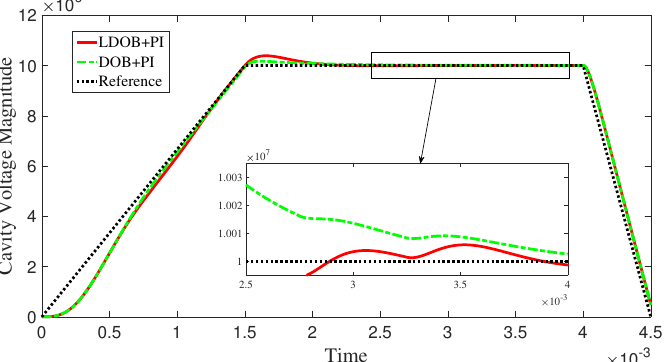
Figure 8. Cavity voltage magnitude for learning-based DOB + PI and conventional DOB + PI controllers, elaborating flat top voltage stability.